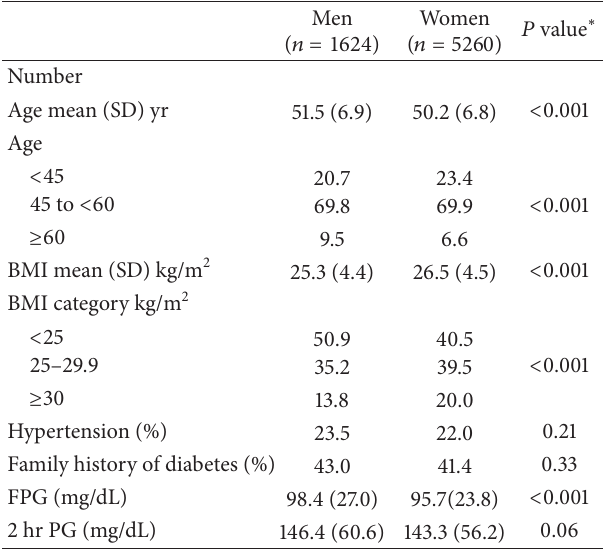
Table 1: Basic characteristics of participants of the screening programforfastingplasmaglucose(FPG)andoralglucosetolerance test